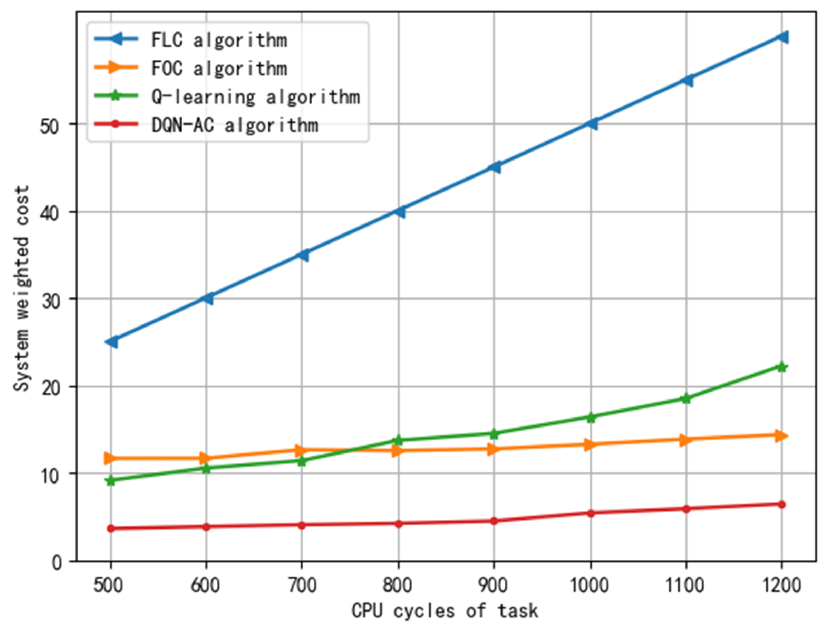
Figure 6. The impact of CPU cycles of task on system weighted cost.